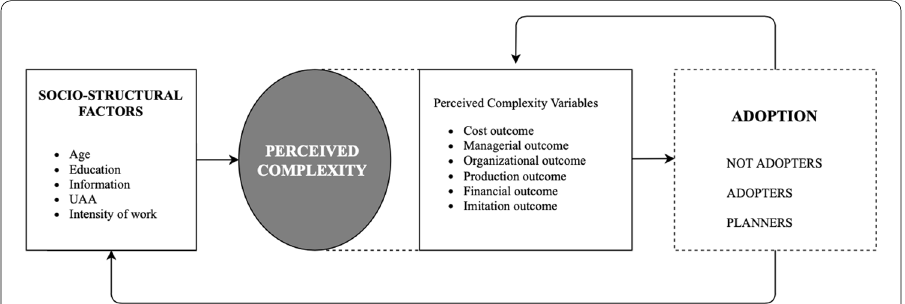
Fig. 2 Conceptual